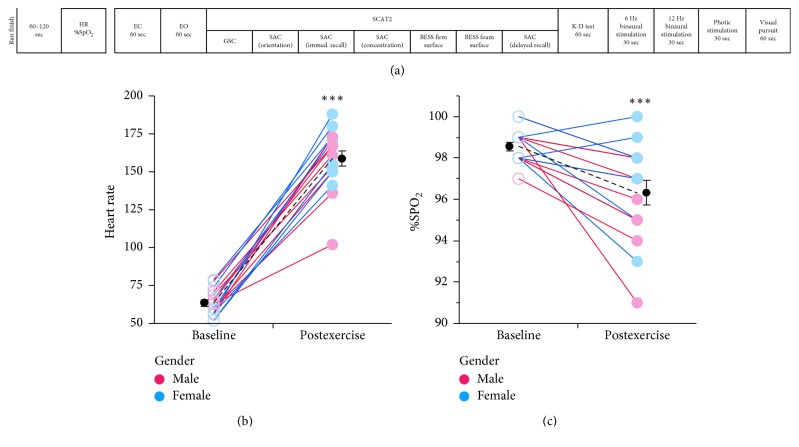
Time course of the 14-task neural assessment protocol and the effect of exercise on heart rate and arterial oxygen levels in collegiate athletes. (a) The 14-task neural assessment protocol conducted before and after the exercise challenge. (b) Heart rate (beats/minute) is plotted before (baseline) and after (postexercise) a timed one-mile run around a grass track. Males (n = 8, red) and females (n = 8, blue) showed similar 250% elevations in heart rate. (c) Following exercise, the average arterial oxygen level (% SpO2) was decreased 2% for both males and females. Data for each subject are plotted individually; group means ± SEM are plotted in black. ∗
p < 0.05; ∗∗
p < 0.01; ∗∗∗
p < 0.001 Wilcoxon test.